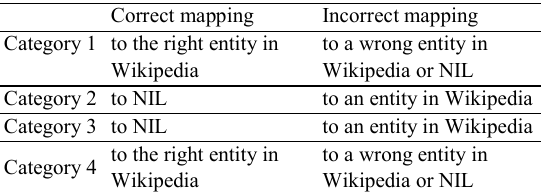
Table 2. Correct and incorrect mention-entity mappings with respect to mention